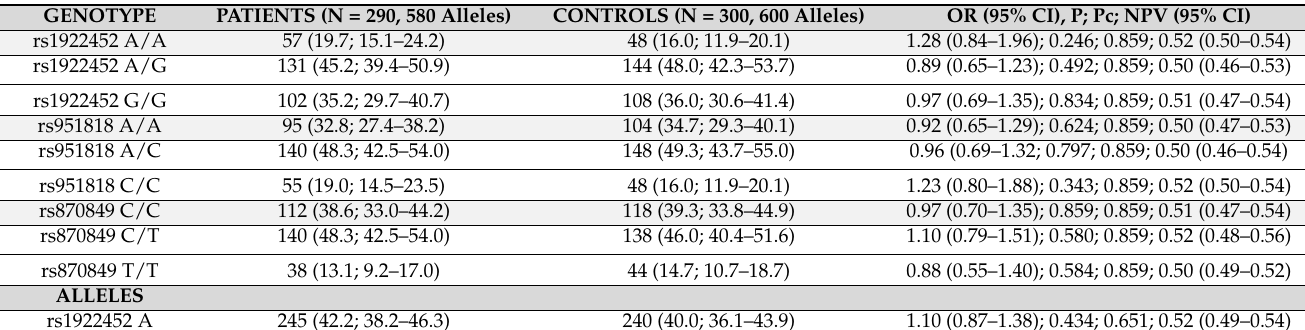
Table 1. Genotypes and allelic variants of patients with migraine and healthy volunteers. The values in each cell represent the number (percentage; 95% confidence intervals). P: crude probability; Pc: probability after multiple comparisons; NPV: negative predictive